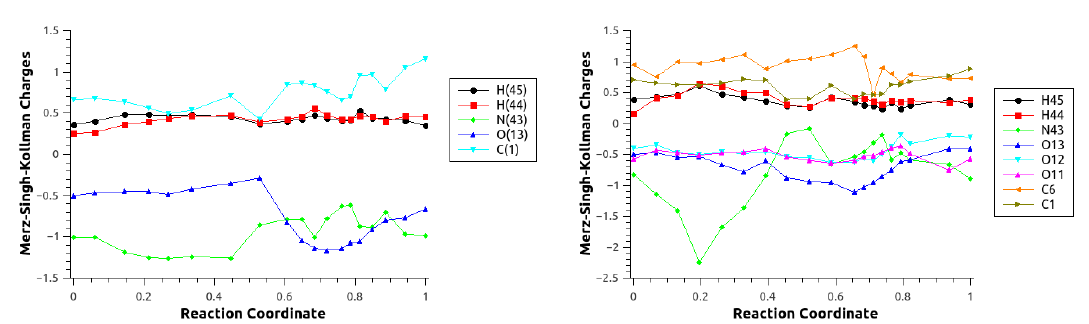
Figure 8. ESP charges for the atoms involved in the MEP for Scheme 1c ( right ) and d left ) for Configuration C2.